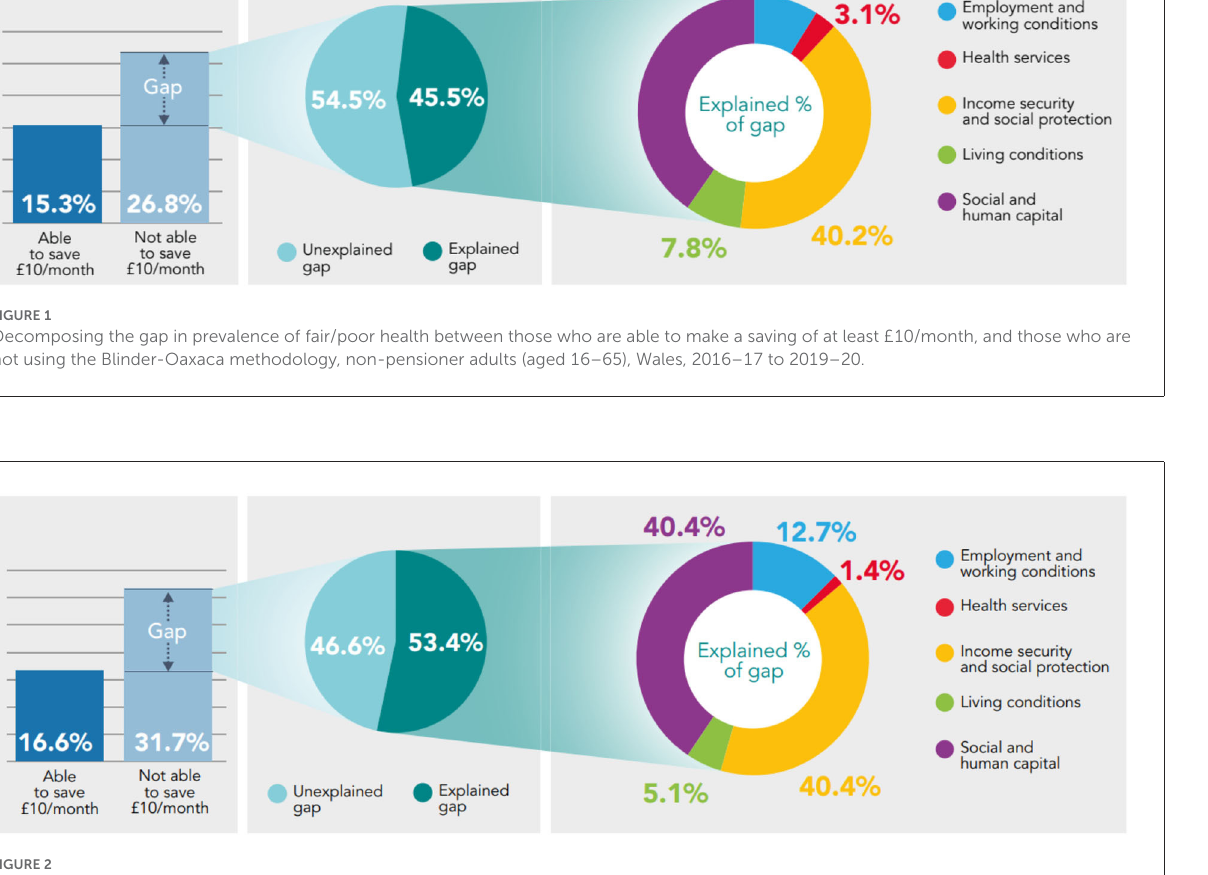
FIGURE2 Decomposing the gap in prevalence of low mental well-being between those who are able to make a saving of at least £10/month, and those who are not using the Blinder-Oaxaca methodology, non-pensioner adults (aged 16–65), Wales, 2016–17 to 2019–20.